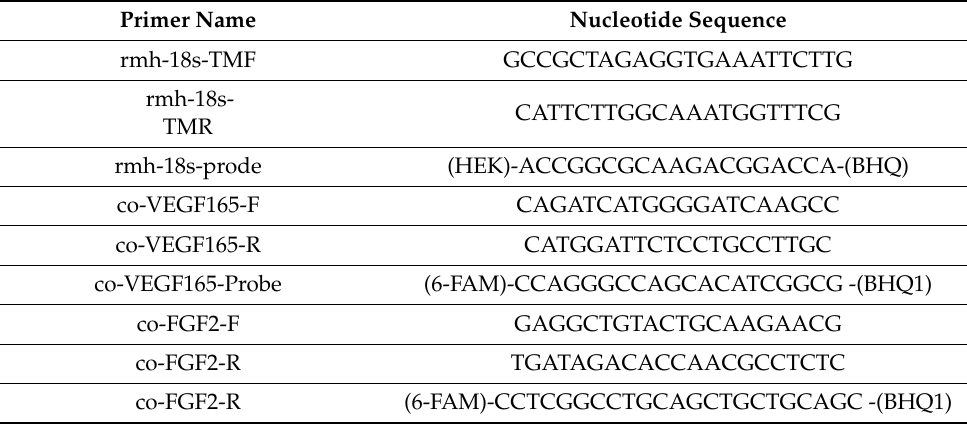
Table 1. Nucleotide sequences of primers and probes used for